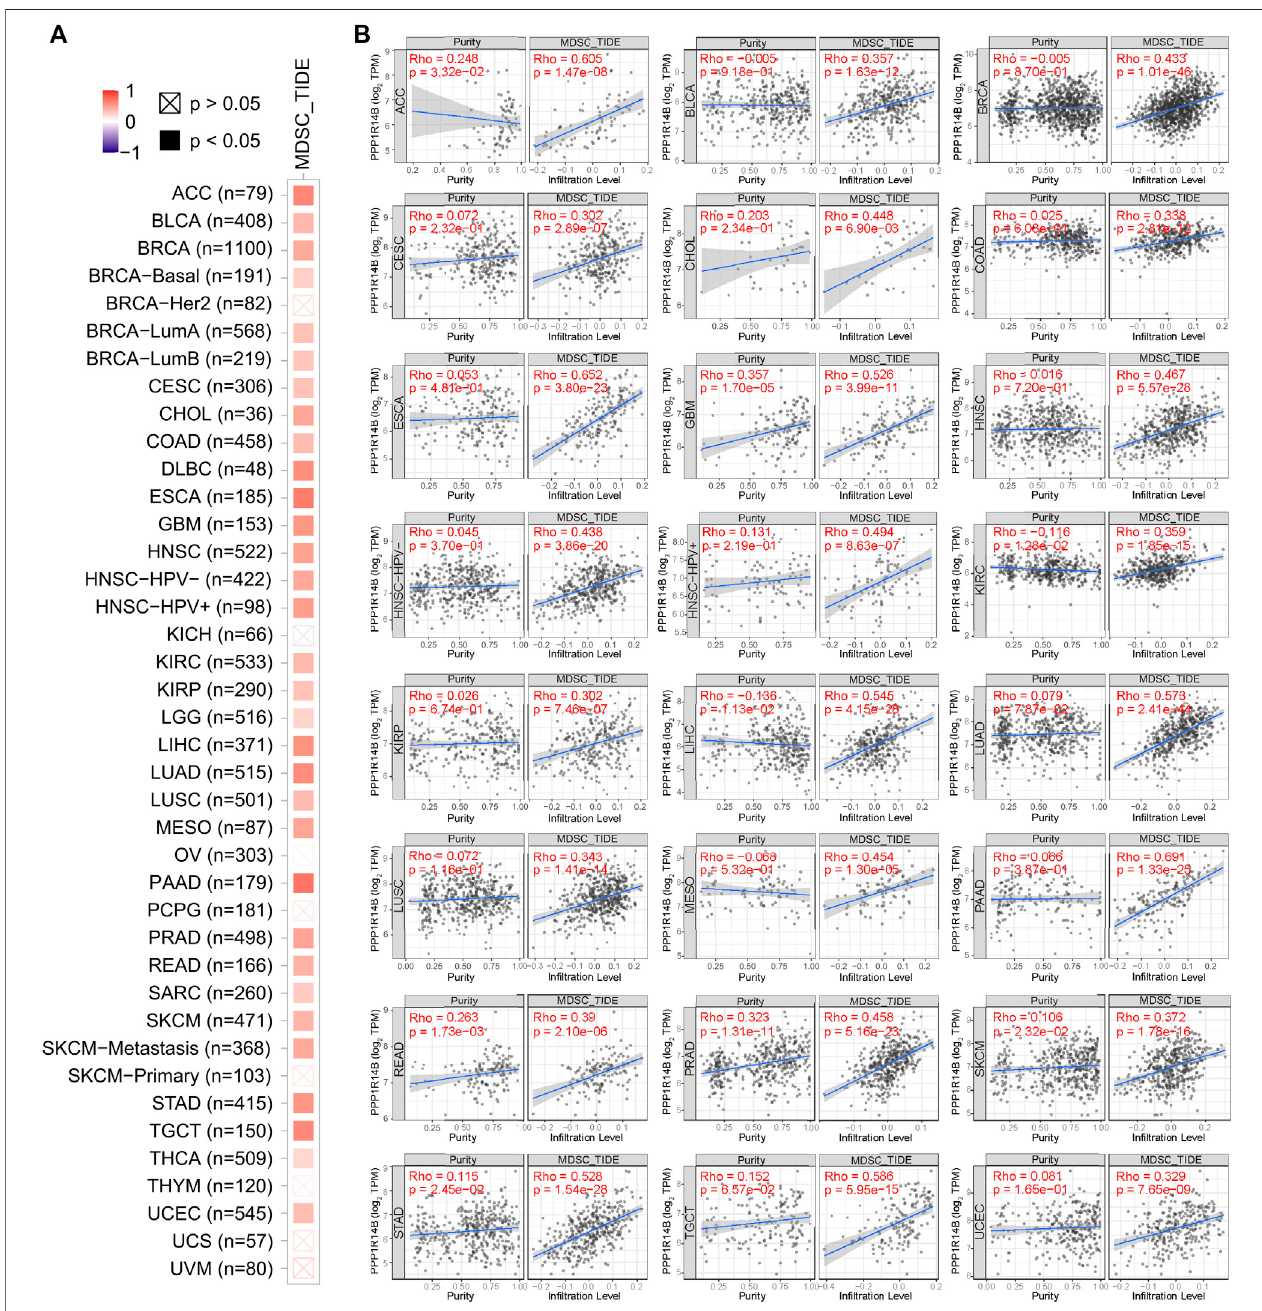
FIGURE 6 | Correlation analysis between PPP1R14B expression and MDSC in fi ltration. Heatmap (A) and scatter plot (B) represented the relationship between MDSC in fi ltration and PPP1R14B gene expression across all types of cancer in TCGA.